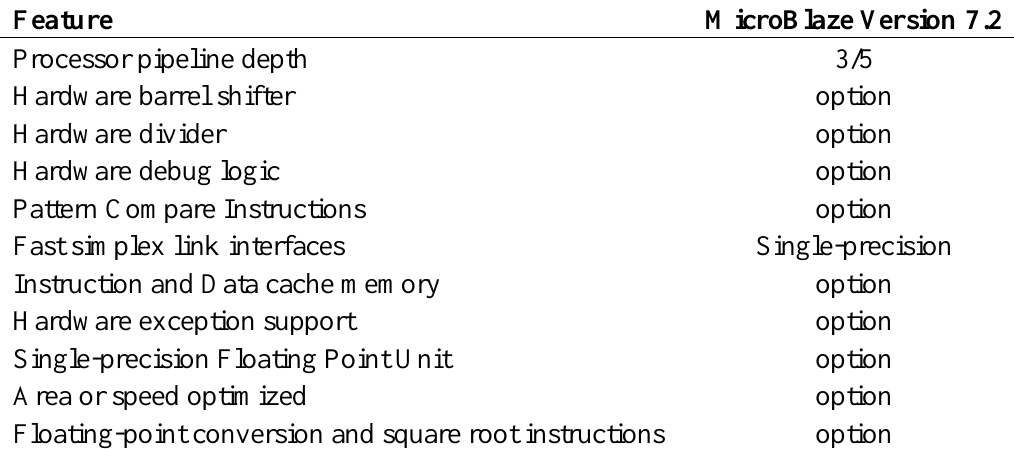
Table 1. MicroBlaze Optional